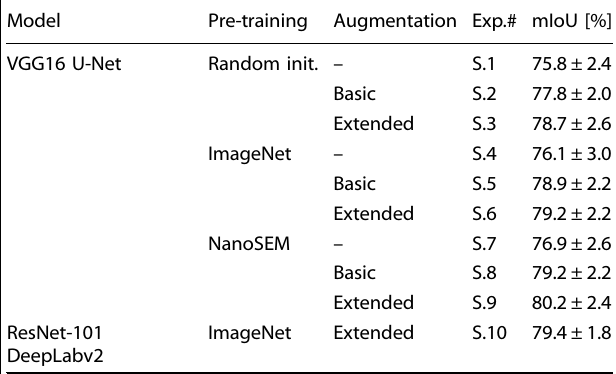
Table 1. Performance of the models trained on the source dataset.